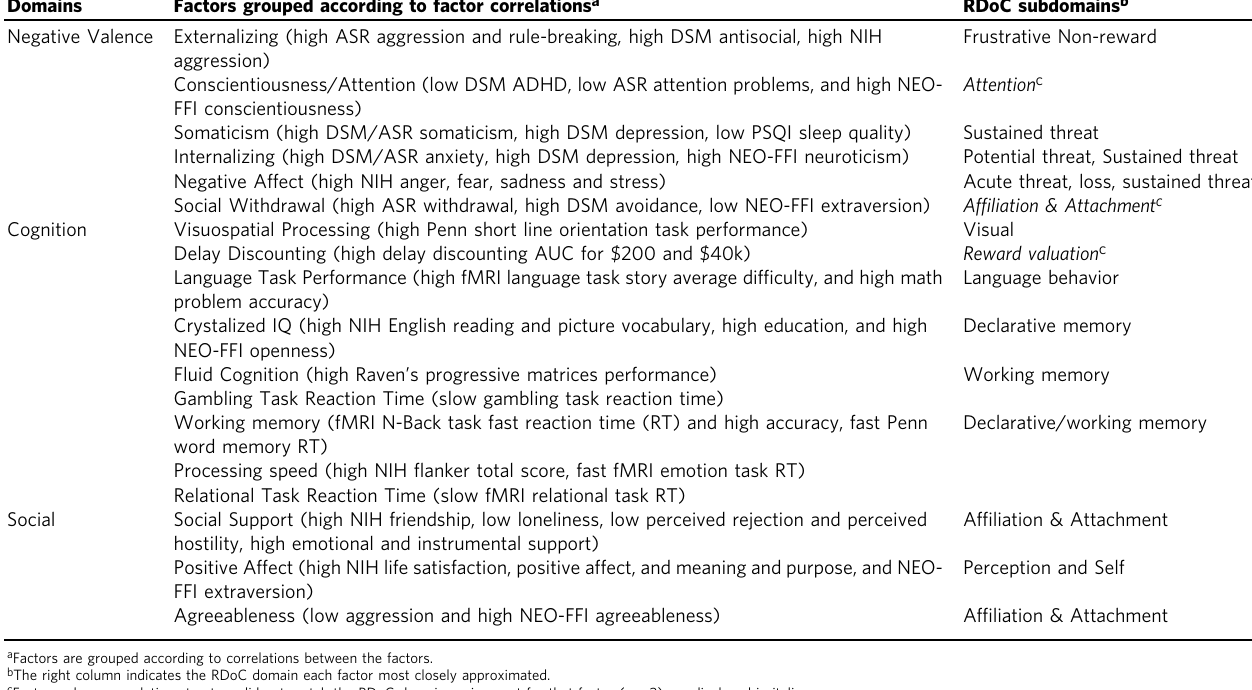
Table 1 Discovered factors (EFA) using 100 phenotypic